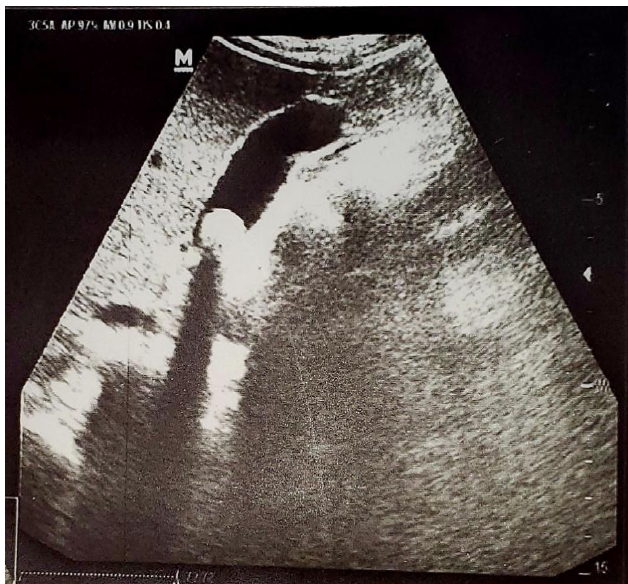
Figure 2: Preoperative ultrasound image of solitary gallstone with long-standing chronic cholecystitis.